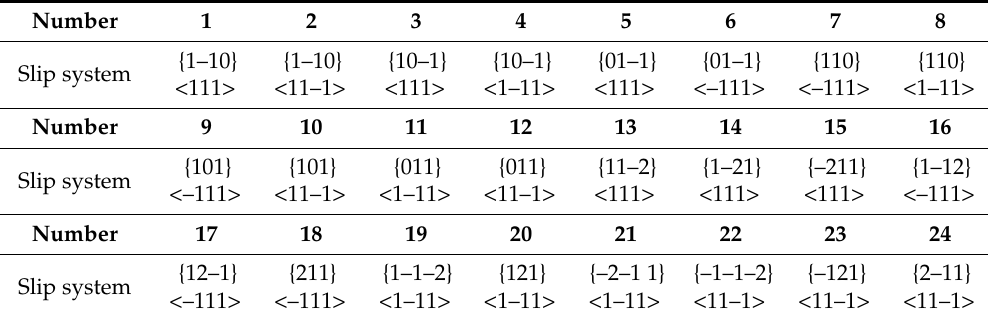
Table 7. Slip systems and reference numbers.